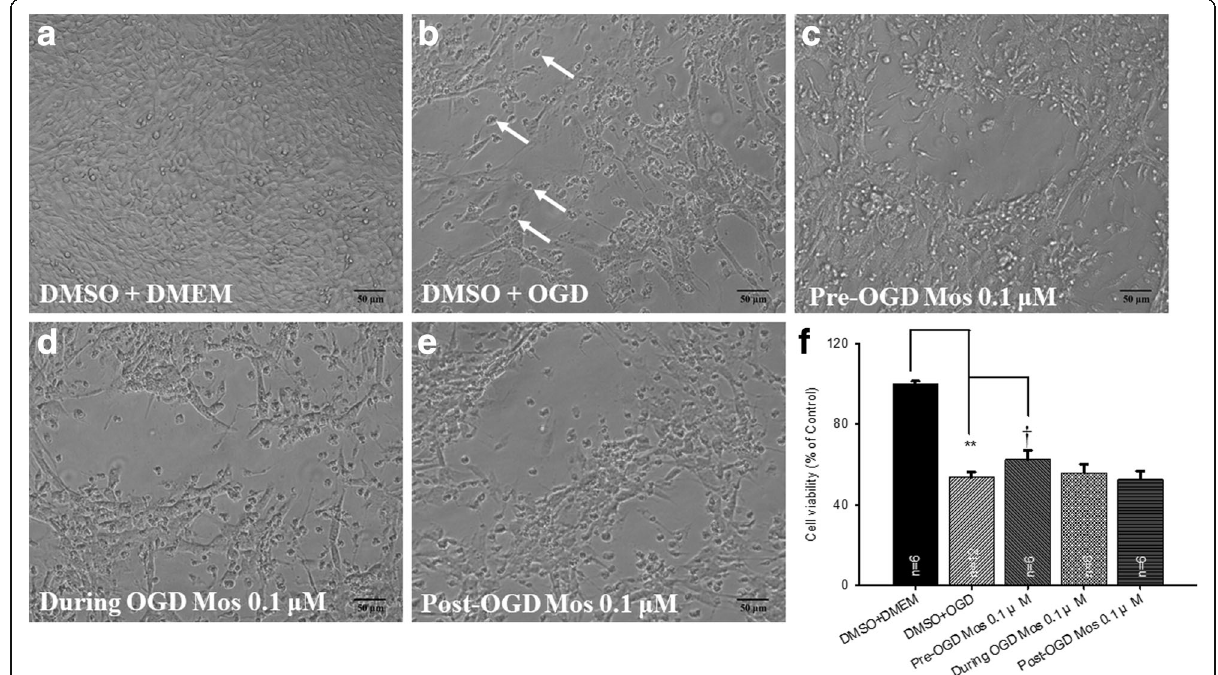
Fig. 1 a ~ e The cell viability study of the effects of moscatilin on RGC-5 cells subjected to OGD using light microscopy. After pre-administration of DMSO (vehicle) followed by OGD (DMSO+OGD), the cells were found to be less numerous and some were deformed (as indicated by arrows) as compared to the normal control group (cells cultured in DMEM and pre-administration of DMSO; DMSO+DMEM). These OGD-induced alterations were mitigated by pre-administration of moscatilin (Mos) at 1 h pre-OGD (Pre-OGD 0.1 μ M Mos). f The effects of moscatilin on cells subjected to OGD analyzed quantitatively by MTT assay. ** indicates a significant difference ( P < 0.01) between the control (DMSO+DMEM) and the “ DMSO +OGD ” group. † indicates a significant difference ( P = 0.04) between the “ DMSO+OGD ” group and the “ Pre-OGD 0.1 μ M Mos ” group. Please refer to Table 1 for definitions of the other two groups, namely “ During OGD 0.1 μ M Mos ” and “ Post-OGD 0.1 μ M Mos ” . Results are presented as means±S.E.M. ( n = 6). DMSO, dimethyl sulfoxide; DMEM, Dulbecco ’ s modified Eagle ’ s medium; OGD, oxygen glucose deprivation; RGC, retinal ganglion cell; MTT, 3-(4,5-dimethylthiazol-2-yl)-2,5-diphenyltetrazolium bromide. Scale = 50 μ